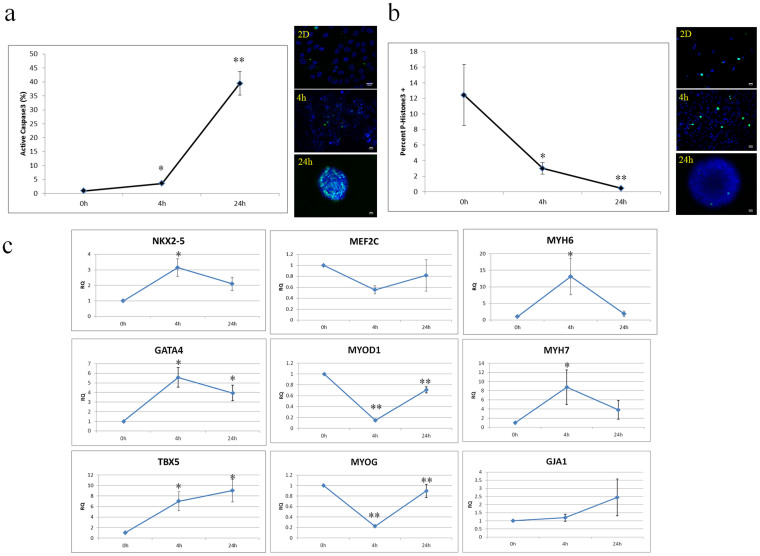
Temporal Effects of Aggregate Formation on MDSCs.(a) Aggregate formation markedly increased active caspase-3 expression (green) of MDSCs. (b) Aggregate formation significantly decreased MDSC phospho histone H3 (green) expression and proliferation. (c) Aggregate formation altered myocyte-specific gene expression patterns. * P < 0.05. ** P < 0.001 vs. baseline. Blue indicates nuclear DAPI staining. Scale bar indicates 20 μm.